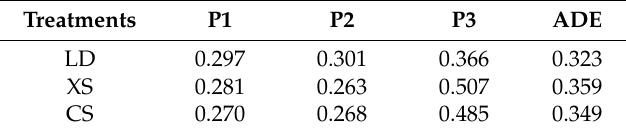
Table 3. Evaporation rate under different sand mulches during the freeze–thaw